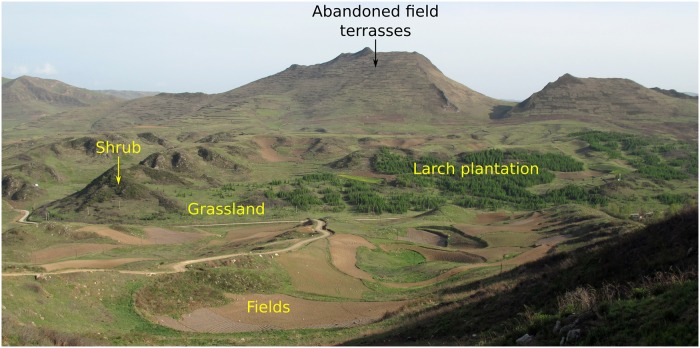
Landscape in May 2015 on the way from CaoTan to SanYanQuan.Ploughing has been banned on former field terraces on steep slopes now left to natural vegetation recolonization, and farming is restricted to flat areas. Reforestation programmes have additionally been carried out since the mid-1990s.